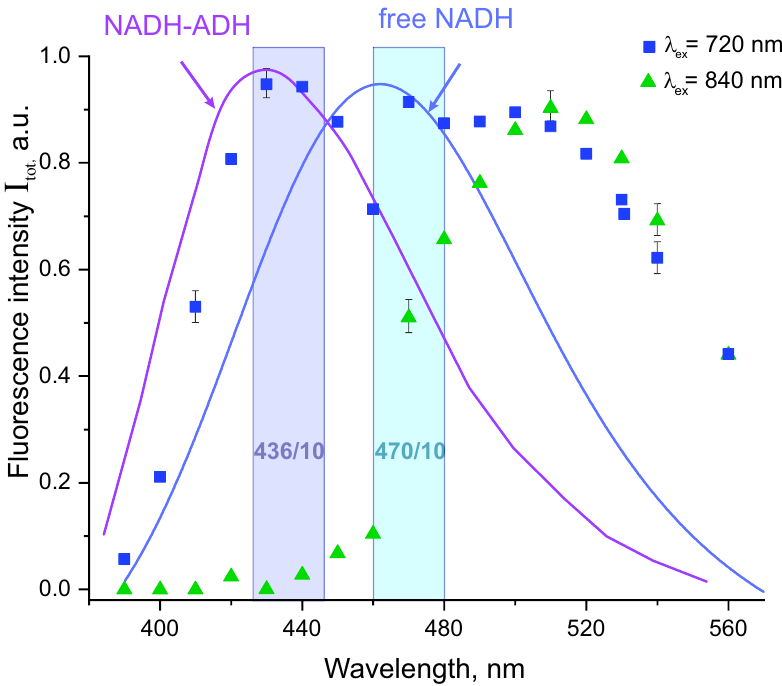
Figure 1. Fluorescence spectrum of the recombinant equine ADH reagent under two-photon excita- tion at 720 nm (blue squares) and 840 nm (green triangles). Blue curve is fluorescence spectrum of free NADH in buffer solution under two-photon excitation at 720 nm recorded in this paper. Violet curve is the fluorescence spectrum of NADH-ADH in buffer solution under one-photon excitation at 330 nm from Ref. [33]. Violet and blue rectangles represent the transmission bands of the bandpass filters 436/10 and 470/10, respectively that were used in time-resolved fluorescence experiments. The fluorescence intensities are normalized to